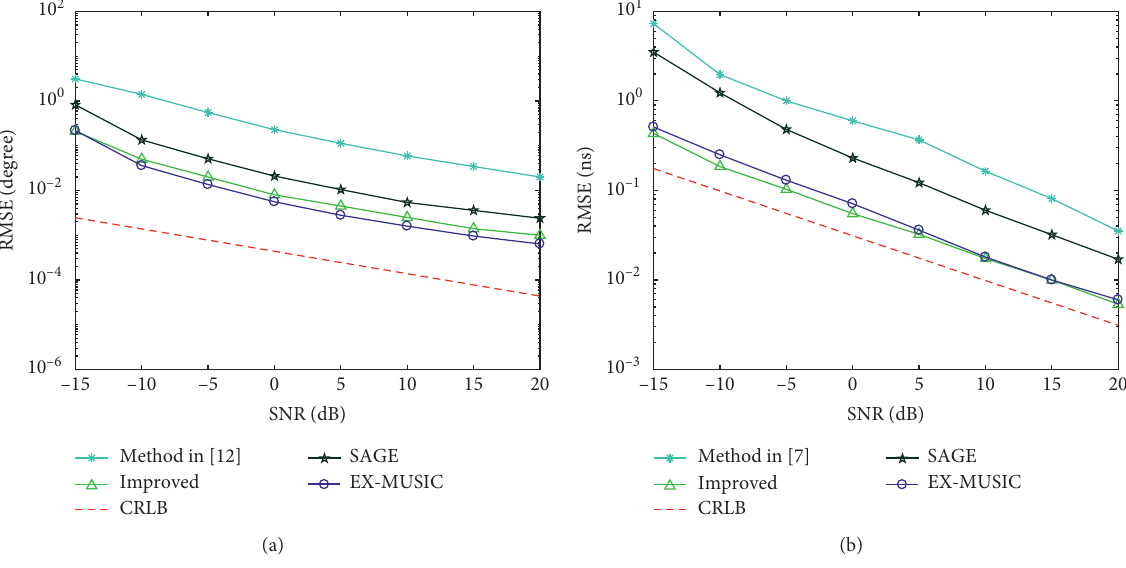
Figure 5: Performance comparison regarding SNR when signals are independent. (a) DOA and (b) time